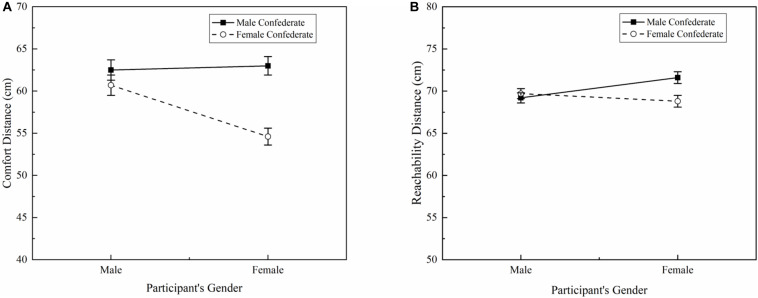
The effect of participant’s gender × confederate’s gender on IPS (A) and PPS (B).